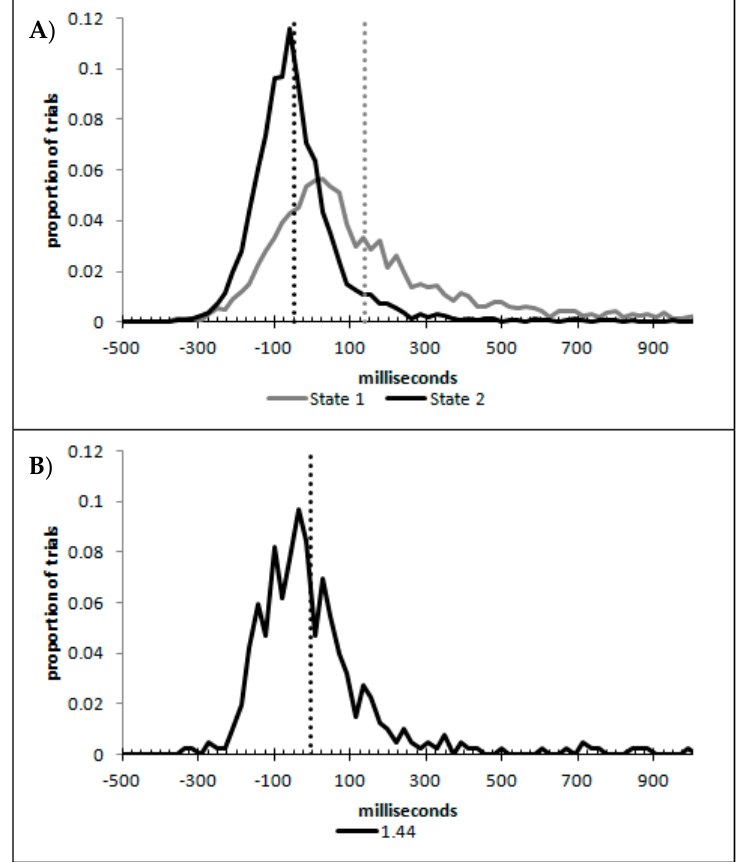
Figure 9. Density functions of ( A ) proposed state 1 (grey line) and state 2 (dark line) and ( B ) an example of a signal strength that may be a mixture of state 1 and state 2 responses.